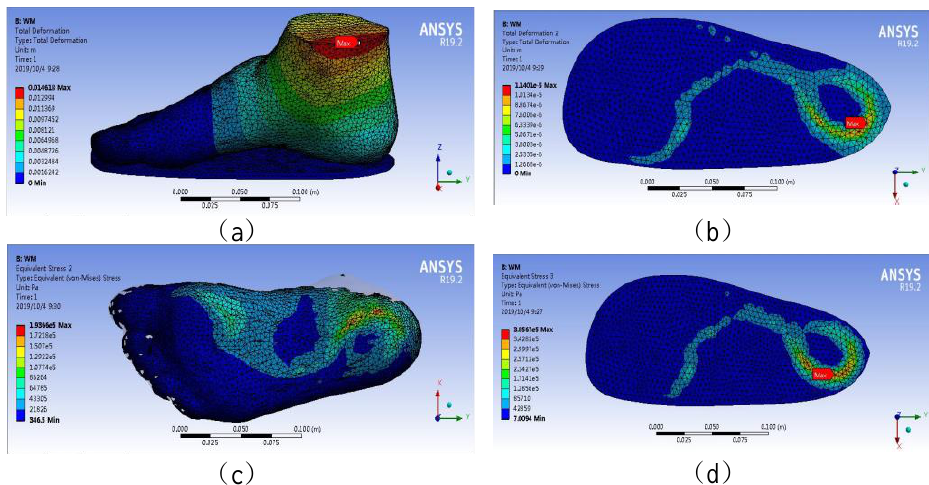
Figure 6. Plantar pressure distribution obtained from WM under 300 N loading. ( a ) model’s total deformation, ( b ) insole deformation, ( c ) plantar pressures, ( d ) insole stresses.